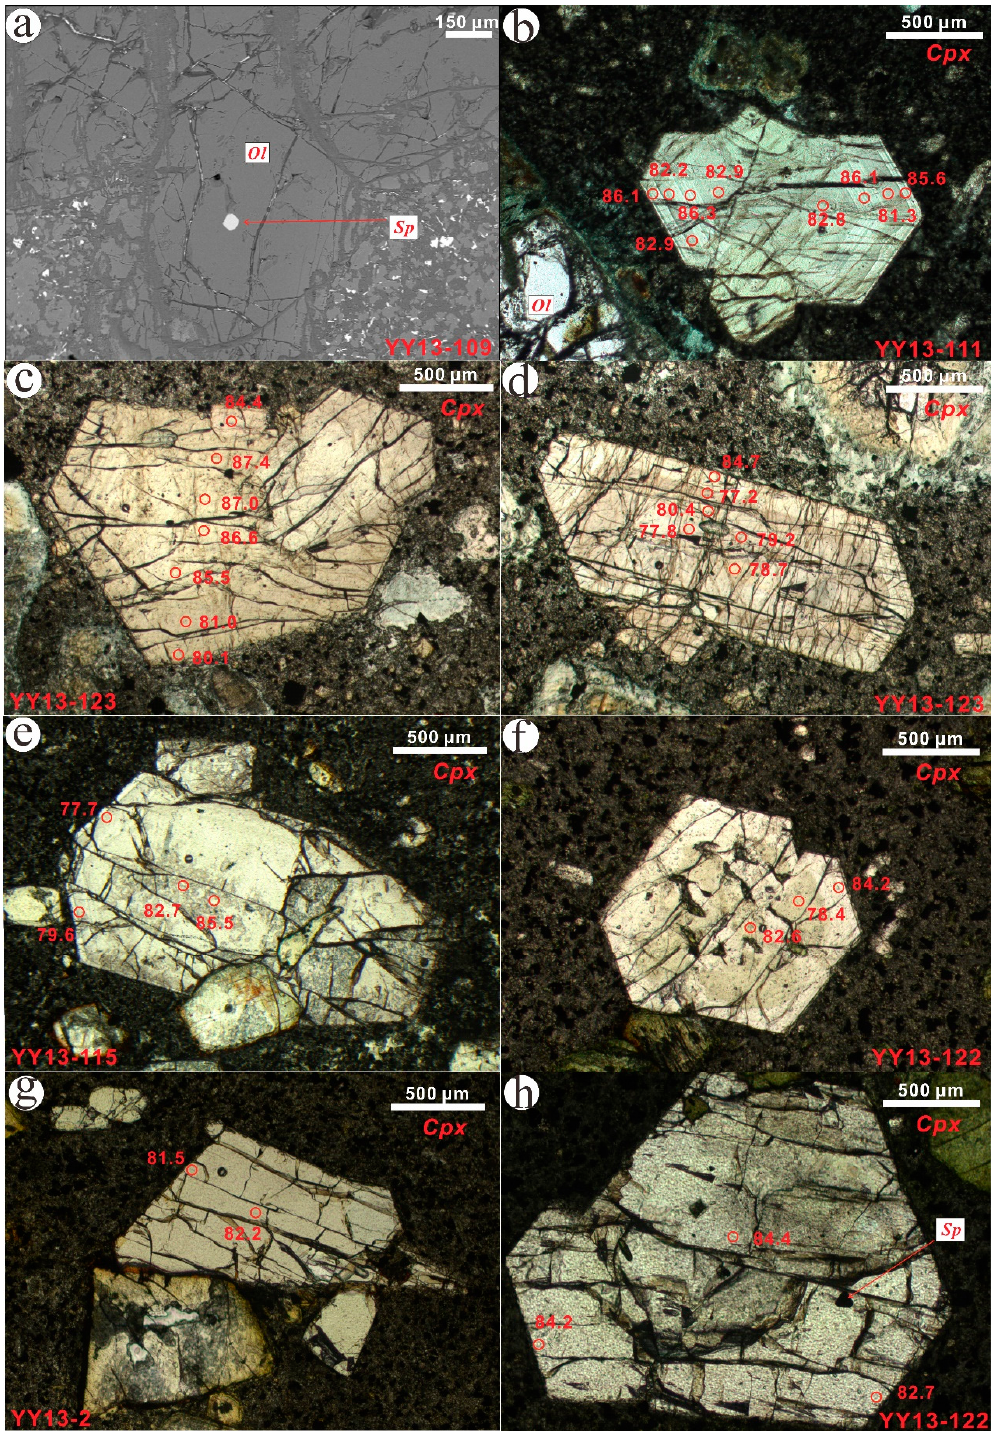
Figure 2. Representative BSE and microphotographs (plane-polarized light) of phenocrysts in studied samples. ( a ) Olivine phenocryst in high-Mg basalt. ( b – d ) Cpx phenocryst in high-Mg basalt. ( e – h ) Cpx phenocryst in low-Mg basalt. (The red square denotes the EPMA analytical spot for major elements. The number beside the red square represents the Mg # [MgO/(MgO + FeO)]. Ol = olivine, Cpx = clinopyroxene, Sp = spinel).